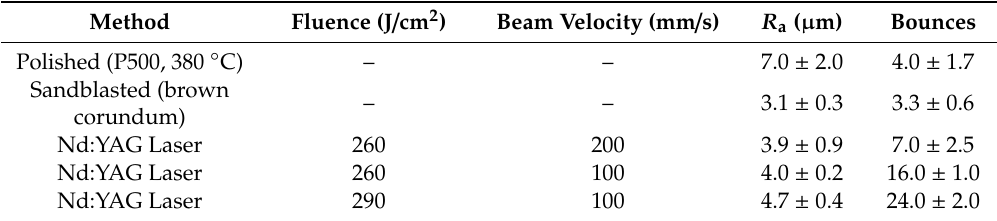
Table 5. Surface roughness ( R a ) and drop bounces for the Nd:YAG laser ablated PTFE coatings processed at the optimum ranges of fluence and velocity. Comparison with the optimum results obtained by other